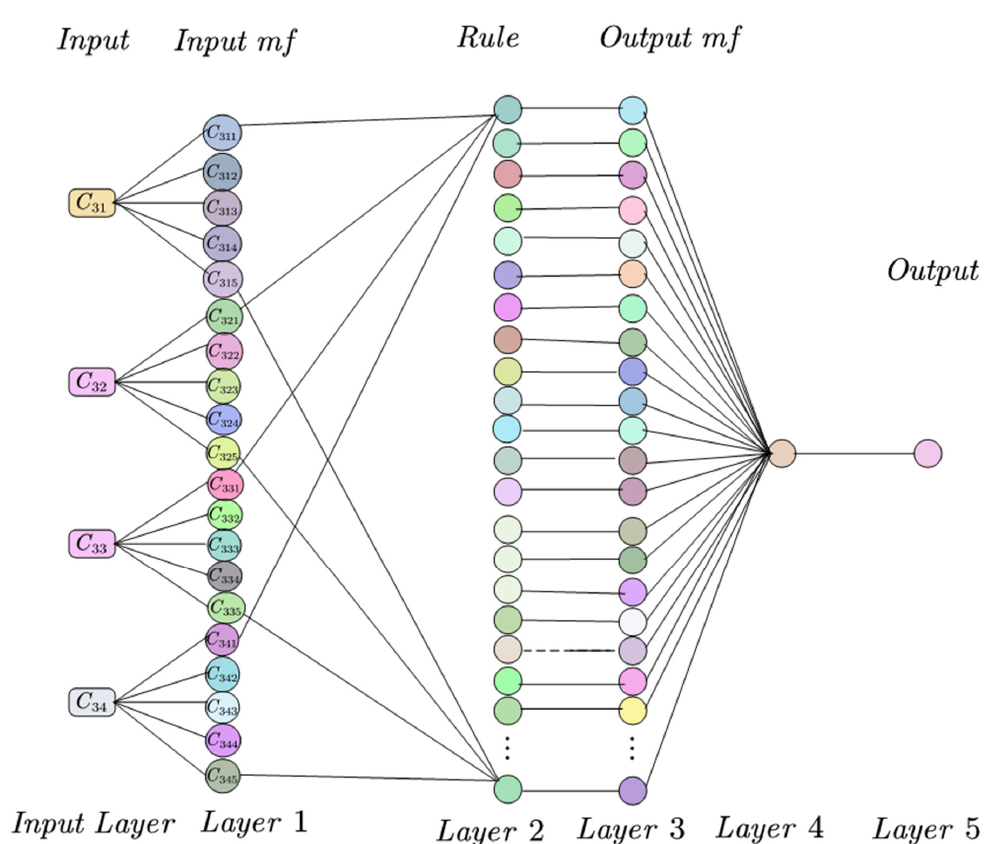
Figure 7. Proposed ANFIS model structure (C 31 : relative dynamic modulus of elasticity, C 32 : cracking resistance ratio, C 33 : water seepage height, and C 34 : carbonization depth).